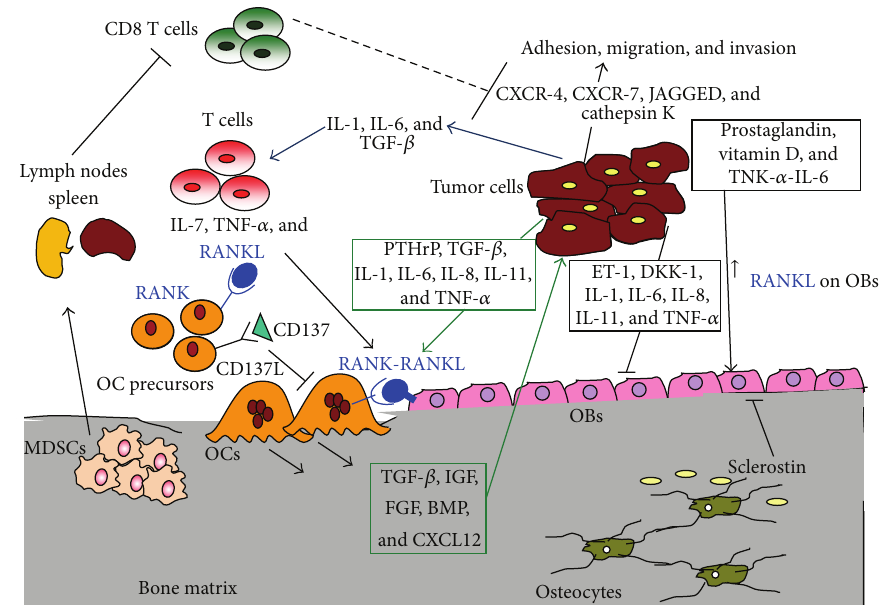
Figure 1: Interactions among bone, immune, and tumor cells sustain the vicious cycle of bone metastasis. Tumor cells release cytokines that activate T cells to produce proosteoclastogenic factors, such as RANKL, which activate OCs. In turn, the release of bone matrix growth factors during bone resorption enhances the tumor growth. MDSCs originate from BM and migrate to secondary lymphoid organs where they inhibit the antitumor immune response mediated by CD8 T cells. Consequently, the increased tumor growth induces the production of osteolytic factors which activates the OCs, the cells responsible for bone